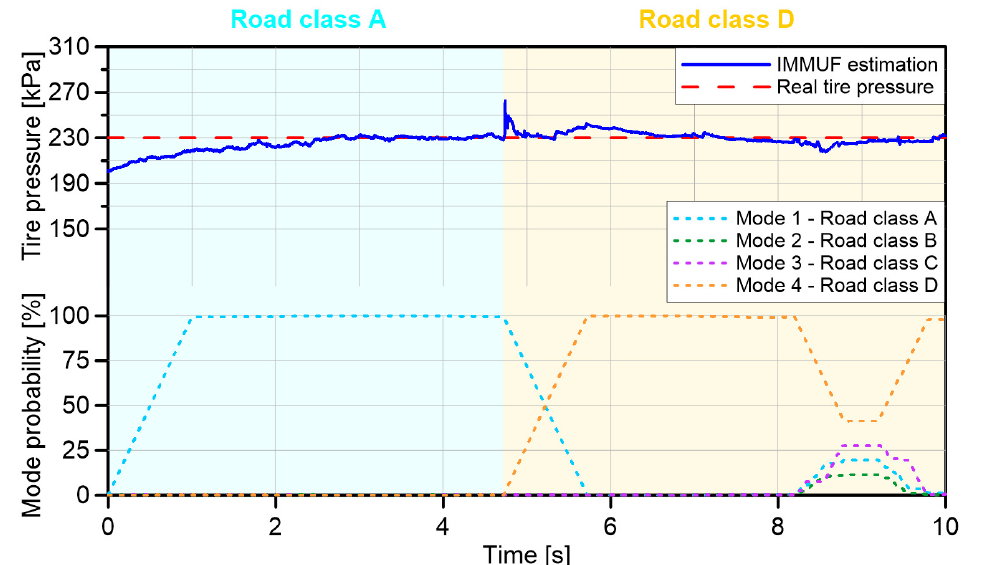
Figure 9. Estimation of tire pressure with abrupt change of class for road surface profile.